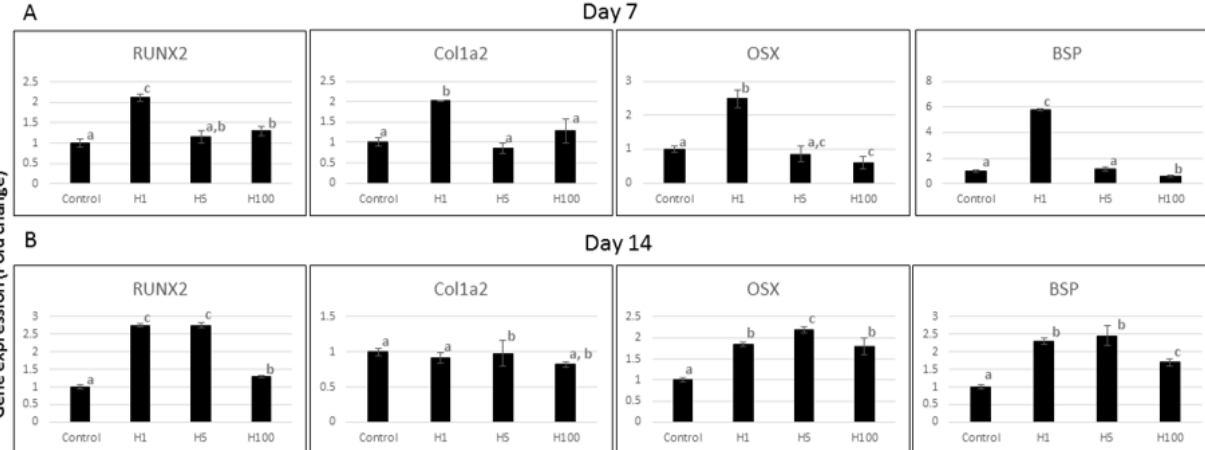
Figure 2. Effect of hesperidin (H) on gene expression of osteogenic markers of MC3T3-E1 pre-osteoblast cells at 7 ( A ) and 14 ( B ) days as analyzed by qRT-PCR. Different superscript letters (a,b,c) indicate statistical difference among groups ( p < 0.05). H, on day 7, at a dose of 1 µM (H1) showed consistent elevation of osteogenic markers compared to control. On day 14, both lower concentrations of H (1 and 5 µM) showed significantly more elevated Runx2, Osx and Bsp ( n = 3/group).